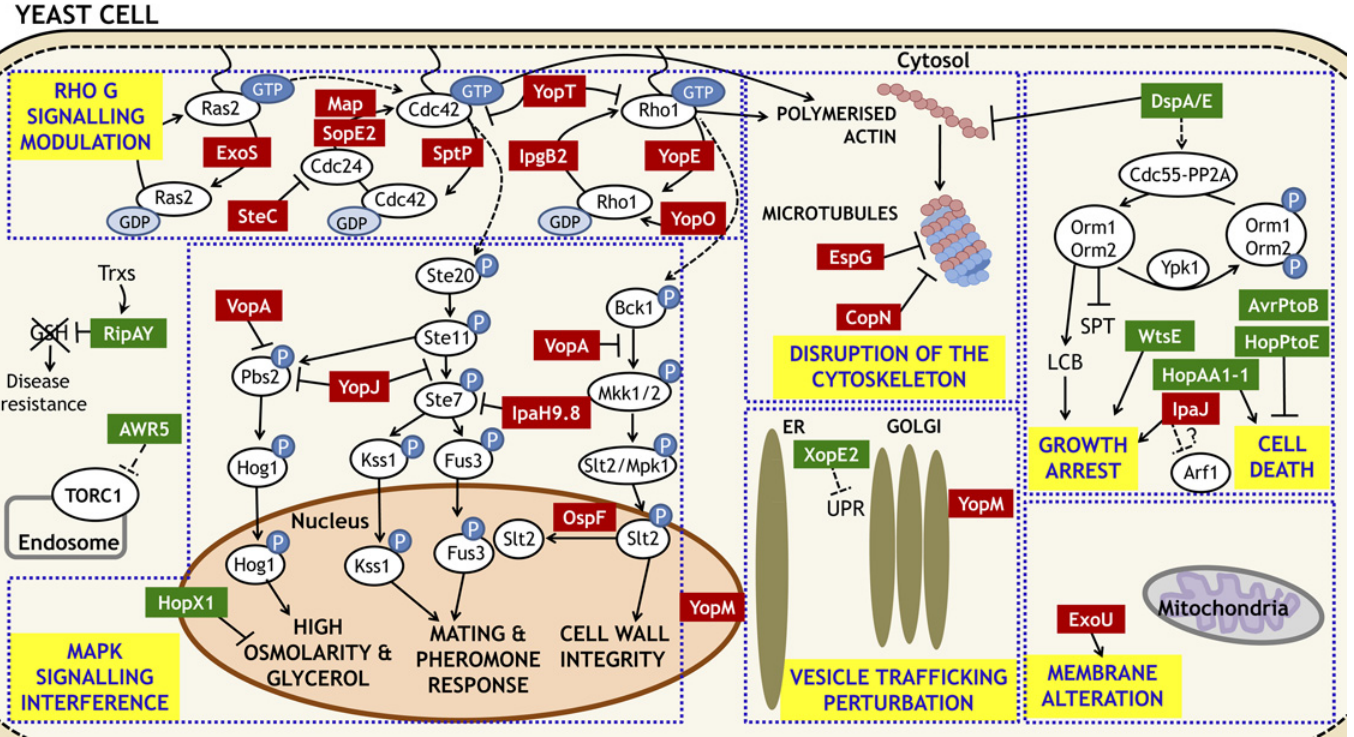
Fig 2. Yeast cellular processes targeted by bacterial T3Es. The key processes targeted are marked in yellow and their components separated by dotted areas. Plant-associated effectors (green squares) and animal-associated effectors (red squares) are indicated next to the activities they modulate. Arrows indicate activation and T symbols indicate inhibition. Abbreviations: UPR: unfolded protein response; SPT: serine palmitoyltransferase; LCB: long chain bases; GSH: glutathione; Trxs: thioredoxins; P: phosphate group. Other common abbreviations are given in the text.